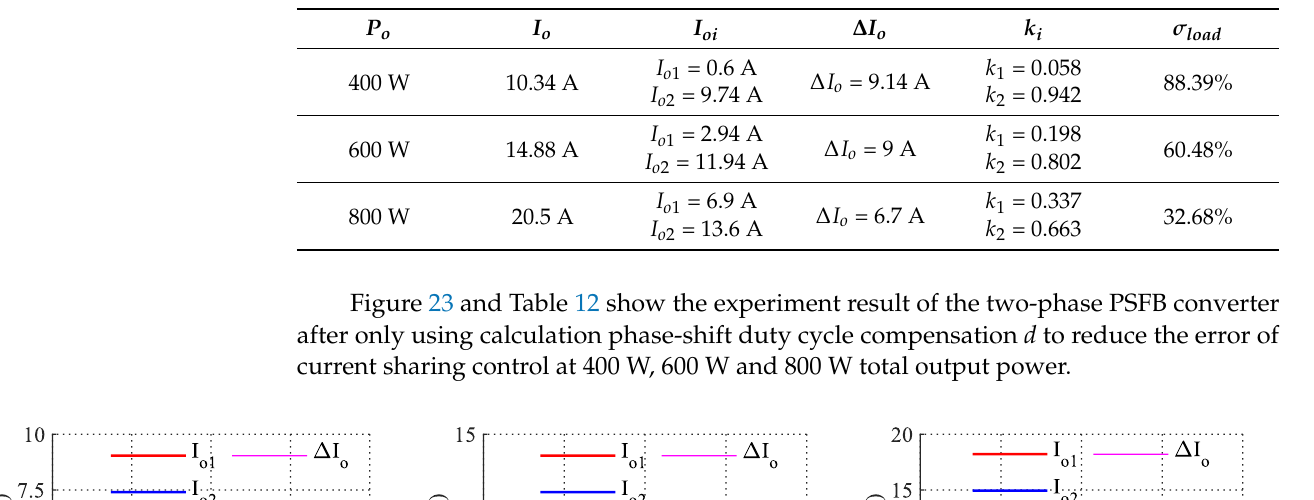
Table 11. Experimental data without current sharing control in different output power.